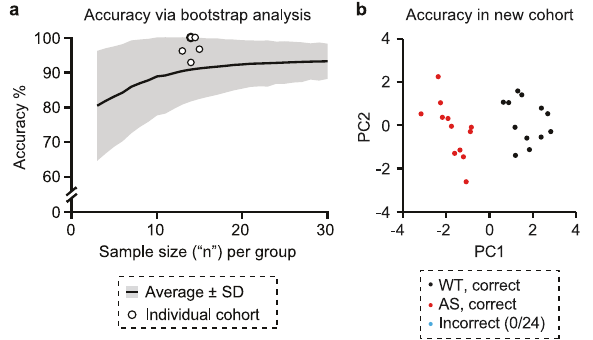
Fig. 4 Multidimensional analysis retains high accuracy with reasonable sample sizes. a Bootstrap analysis was performed using Dataset 1, and 10,000 trials per n . Open circles indicate the clustering accuracy within six individual cohorts. The bold circle represents the overlap of two cohorts with the same ( x , y ) coordinates (14, 100%). b Clustering accuracy using Dataset 2 ( n = 12 per genotype) was